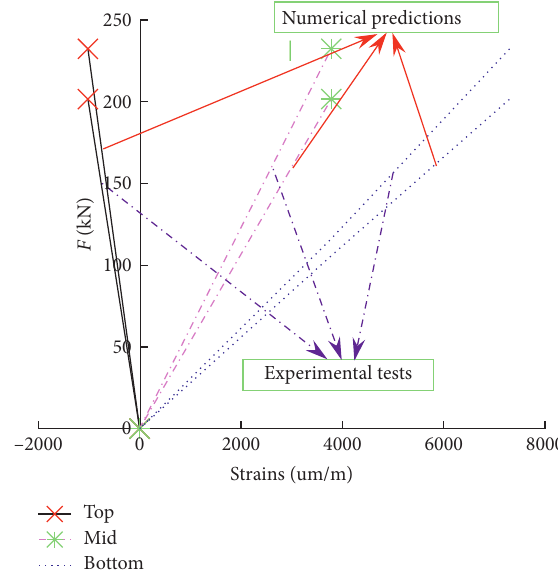
Figure 8: Failure test: mid-span average strains up until